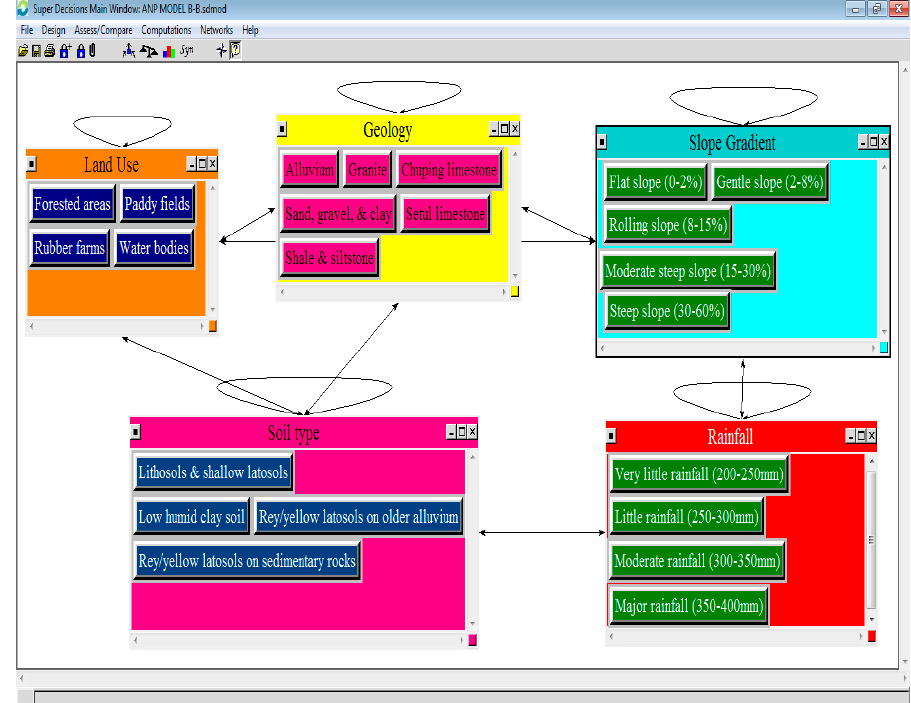
Figure 5. ANP-based network of the flood susceptibility assessment. Table 5. Priority vectors of the